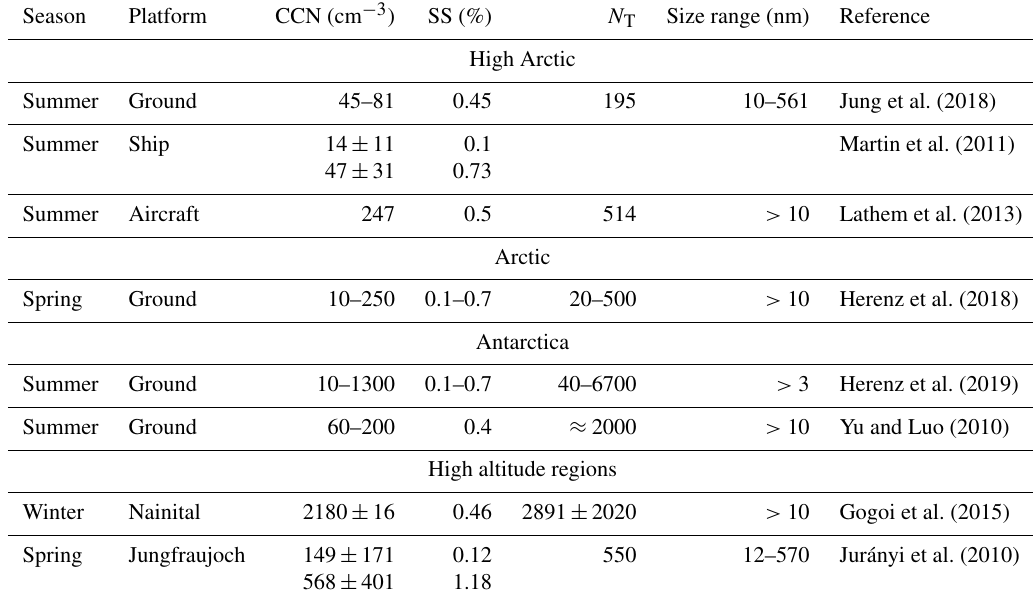
Table 2. CCN and N T concentrations from other